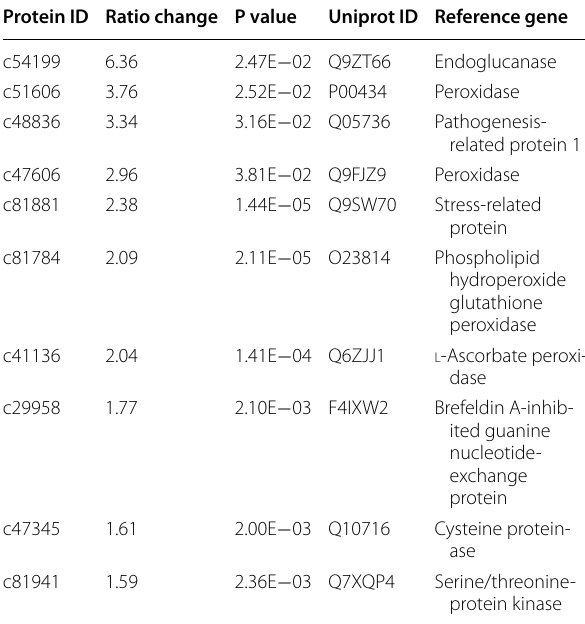
Table 2 Defense genes involved in symbiotic germination of G.